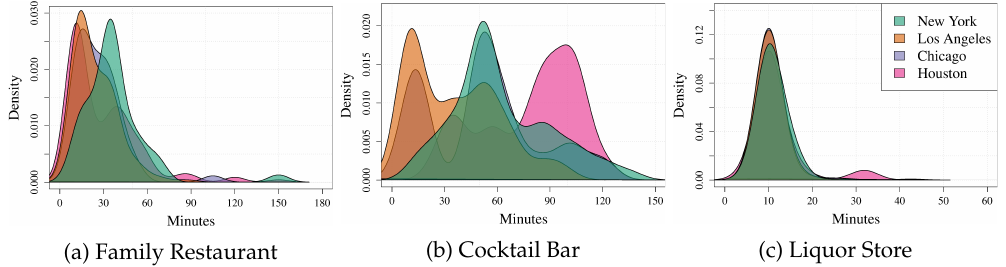
Figure 3: Density plots of visit duration for three place types in January 2021, during the third wave of the COVID-19